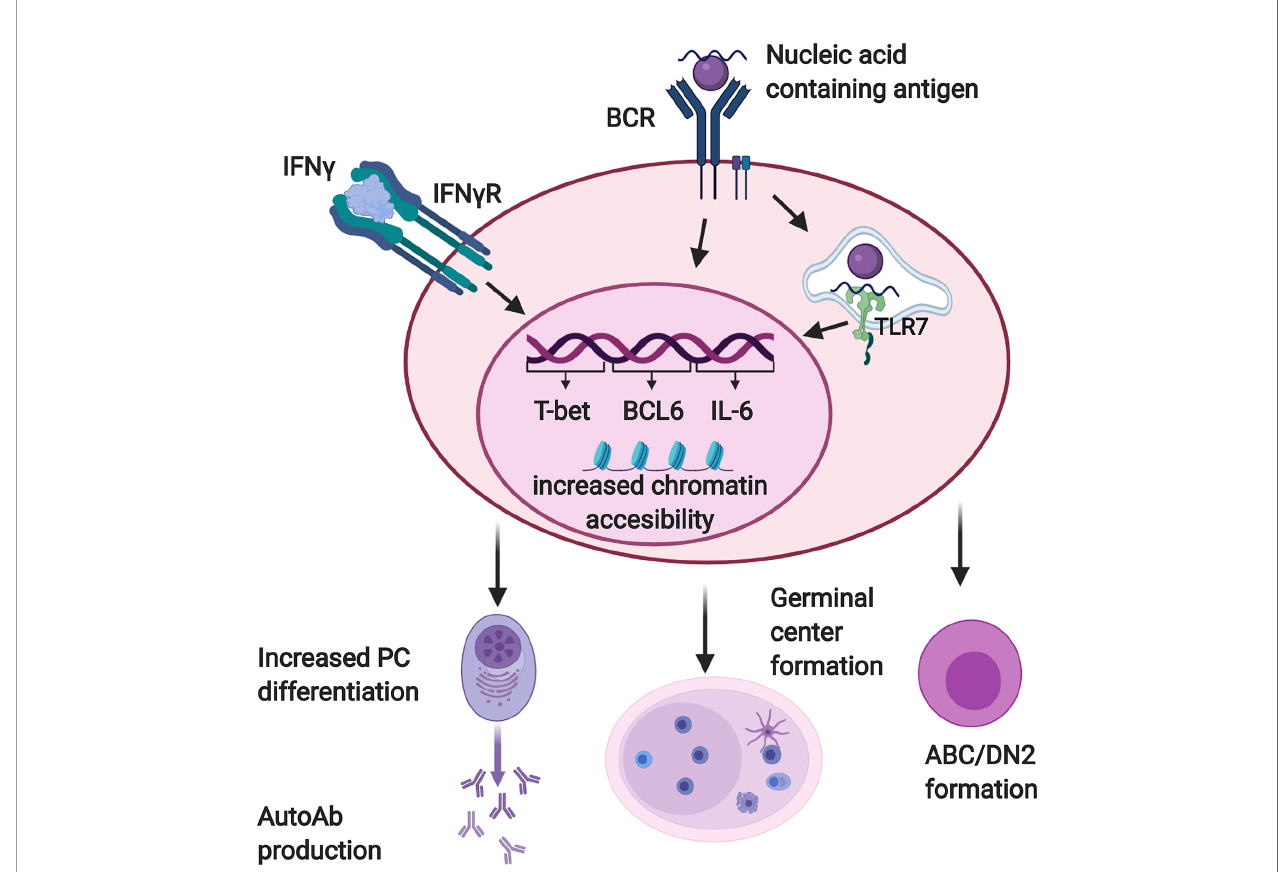
FIGURE 2 | Interferon g (IFN g ) promotes autoreactive B cell activation and differentiation. B cells reactive with nucleic acid containing antigens receive dual activating signals via the BCR and endosomal, nucleic acid sensing Toll-like receptors (TLRs) including TLR7. Autoreactive B cells must also respond to IFN g in order to produce autoantibodies and form germinal centers. When these three signals are received together, B cells upregulate factors which promote autoantibody production and germinal center formation, including T-bet, BCL-6, and IL-6. They also demonstrate increased chromatin accessibility at motifs for transcription factors that promote differentiation of DN2/ABC cells and plasma cells. Created with